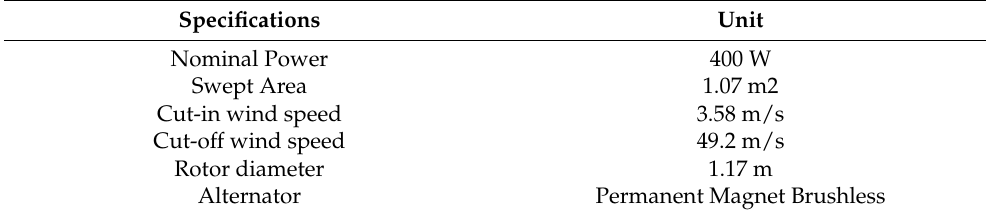
Table 1. Wind Turbine Specifications.